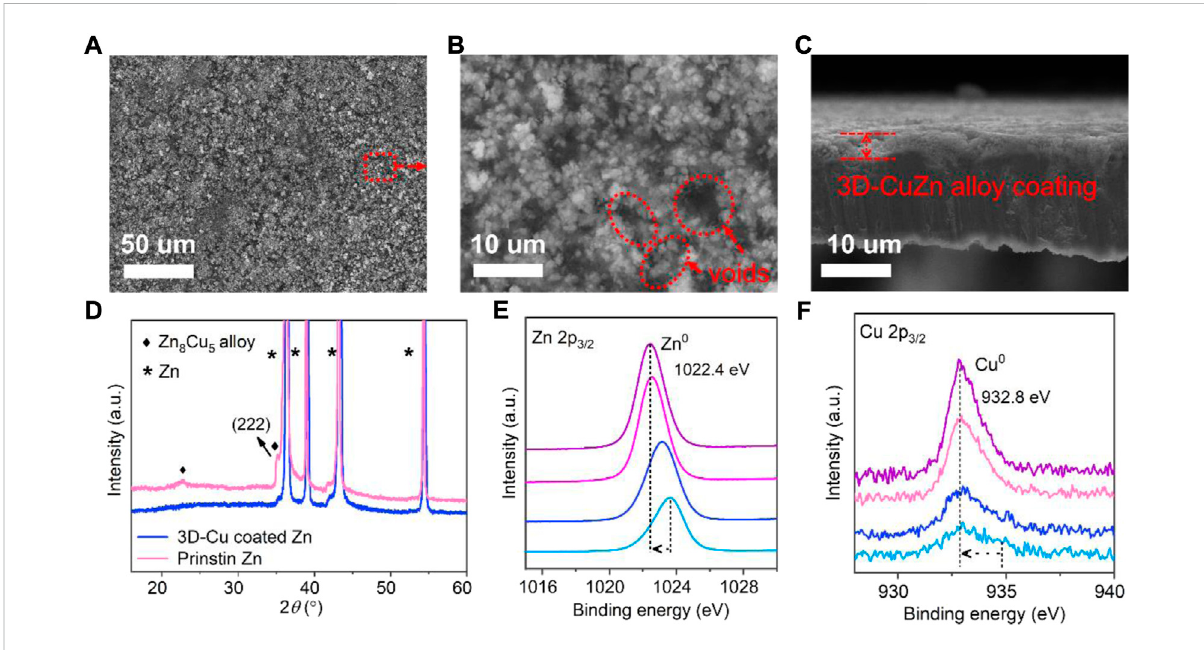
FIGURE 1 Characterizations of 3D-Cu-coated electrodes and bare Zn. (A) SEM image and (B) magni fi ed image from the marked-out region in (A) . (C) Cross-sectional SEM image of the 3D-Cu-coated electrodes. (D) XRD result of these two Zn electrodes. (E,F) XPS results on the depth etching pro fi les of Zn and Cu, where the arrow points from the initial state to the fi nal state throughout the etching process,